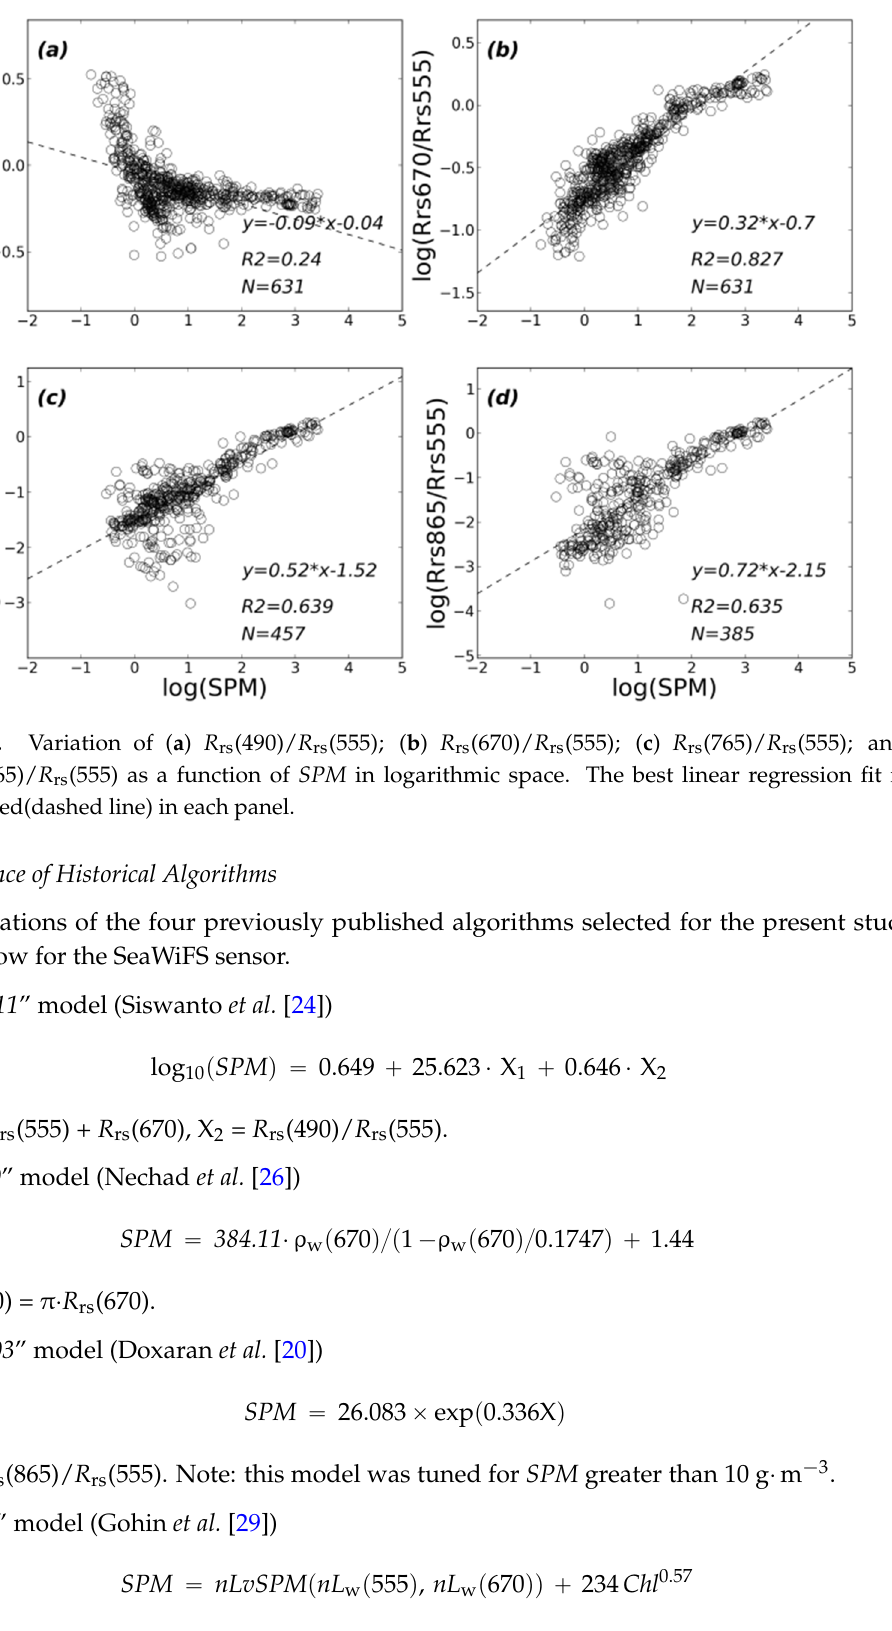
Figure 4. Variation of ( a ) R rs (490); ( b ) R rs (510); ( c ) R rs (555); ( d ) R rs (670); ( e ) R rs (765); and ( f ) R rs (865) as a function of SPM in logarithmic space. The best linear regression fit is also plotted(dashed lines) in each panel.